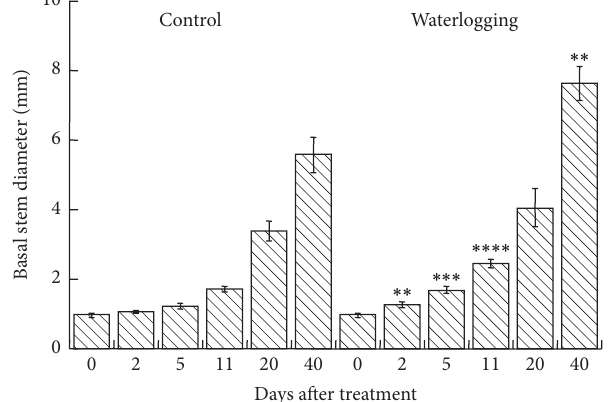
Figure7:Changesinbasalstemdiameterinexperiment 2. ∗∗∗∗ , ∗∗∗ , ∗∗ ,and ∗ Significantlydifferent( 𝑃 < 0.0001 , 𝑃 < 0.001 , 𝑃 < 0.01 ,and 𝑃 < 0.05 ) between control and waterlogging treatment at the same sampling day. Error bars give ± one SE ( 𝑛 = 3 ).